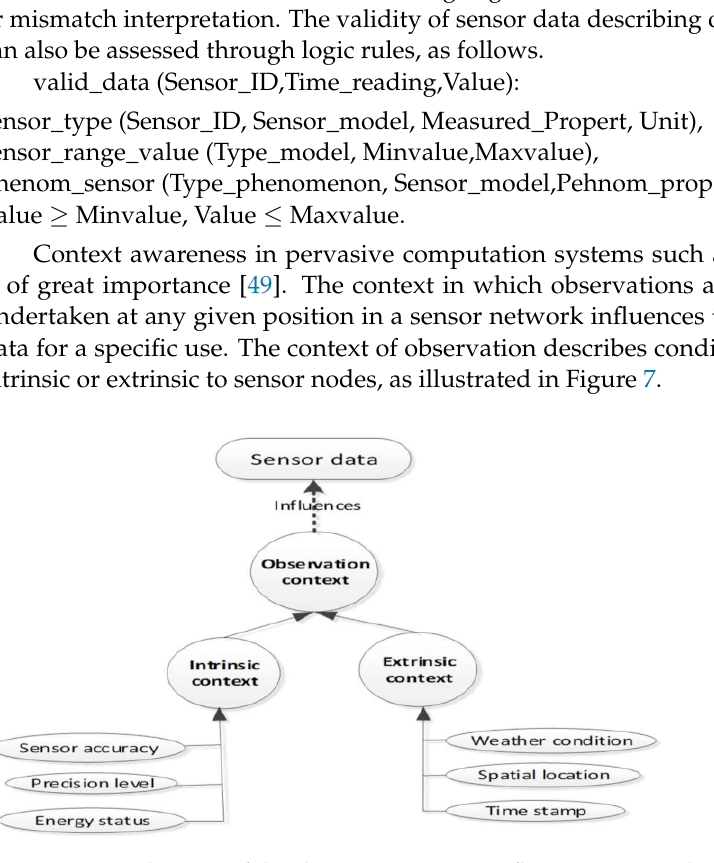
Figure 7. Some elements of the observation context influencing sensor